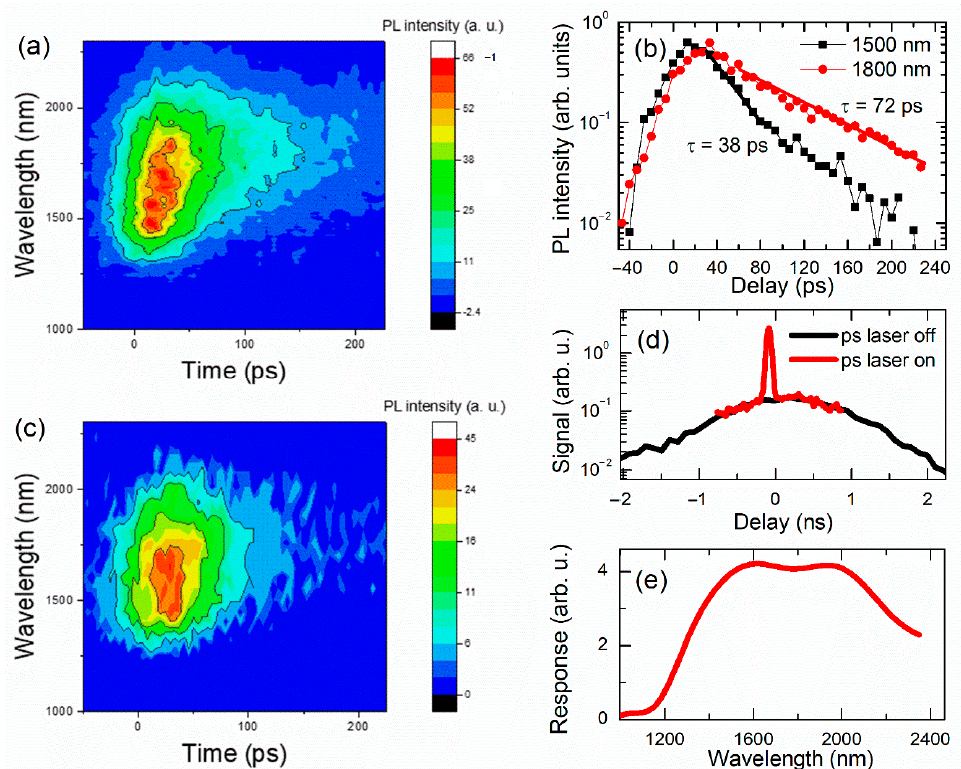
Figure 5. Upconversion with gating probe: PL map ( a ) and corresponding decays at different wavelengths ( b ). PL map upconverted with streak camera ( c ), temporal shape of a scattered 1064 nm excitation pulse, obtained by the upconversion with the nanosecond pumping pulse, and detected at 532 nm wavelength ( d ), spectral responsivity curve of the system including blocking filter ( e ).